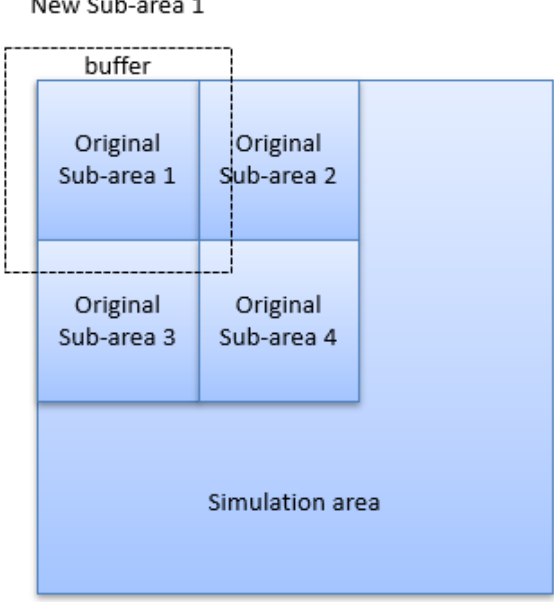
Figure 3. Buffer Figure 3. Buffer method. Figure 3. Buffer method.